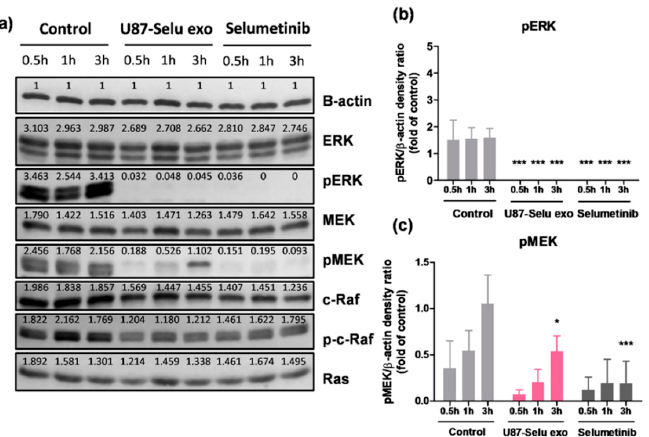
Figure 14. Anticancer mechanism of U87-Selu exo compared with selumetinib. ( a ) Western blot of each group treated for 0.5, 1, or 3 h. ( b ) pERK expression levels of control, U87-Selu exo, and Selu only. ( c ) pMEK expression levels of control, U87-Selu exo, and selumetinib only. * p < 0.05, *** p < 0.001 vs. non-treated control for each time point, n = 3.